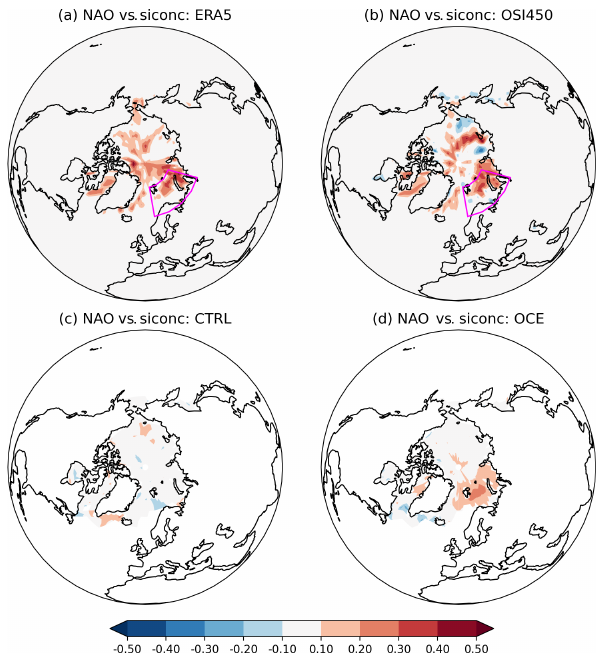
Figure 4. Correlations between the detrended November siconc anomalies at each grid point and the DJF NAO time series, over the period 1980–2015, in (a) ERA5, (b) OSI450, (c) CTRL, and (d) OCE. The ensemble members of the CTRL and OCE experi- ments have all been concatenated together. For the CTRL and OCE plots (c) and (d) , every grid point outside the zero contour is sta- tistically significant ( p < 0 . 05). For ERA5 and OSI450, only grid points in the Barents and Kara seas are significant. In (a) and (b) the Barents–Kara region has been marked by a purple